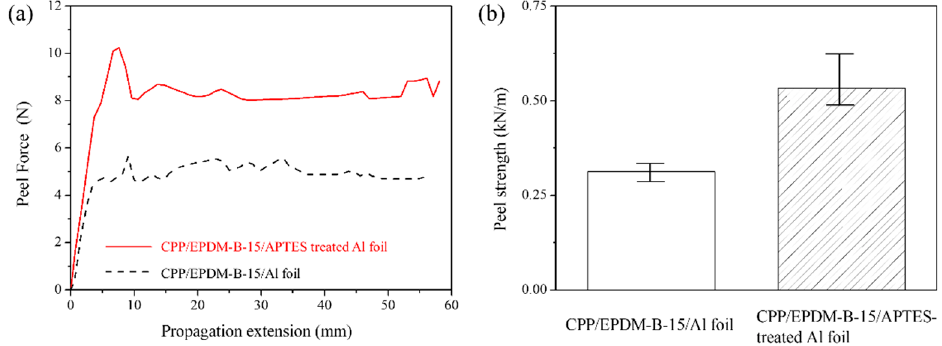
Figure 9. Results of the 180° peel test after tempering at 80 °C for 1 day: ( a ) typical peel force (N) vs. propagation extension (mm) of CPP/EPDM-B-15/APTES-treated Al foil and CPP/EPDM-B-15/Al foil, ( b ) peel strength (kN/m) of CPP/EPDM-B-15/APTES-treated Al foil and CPP/EPDM-B-15/Al foil.